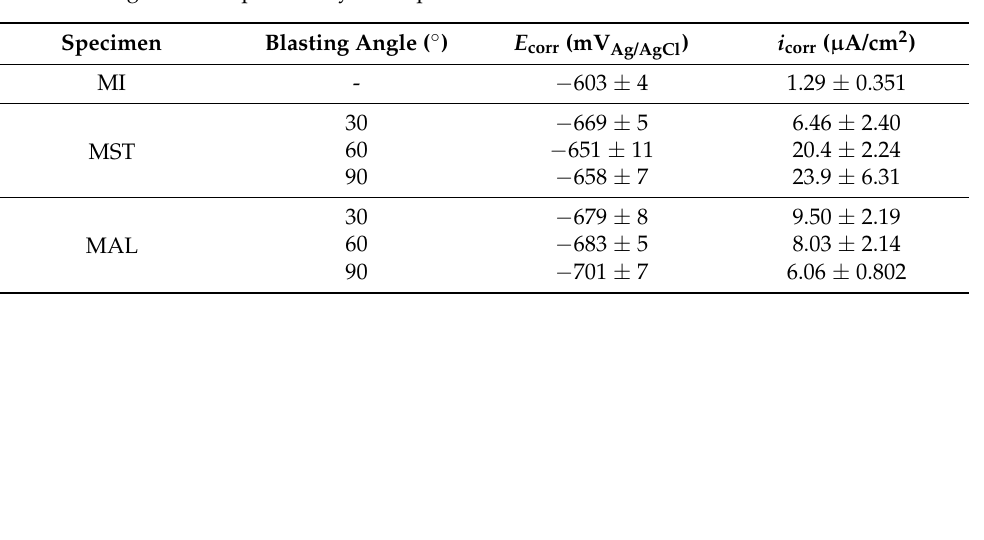
Figure 10. Potentiodynamic polarization curves of the blasted specimens in 3.5 wt% NaCl solution: ( a ) MST, ( b ) MAL. Table 6. Fitting results of potentiodynamic polarization